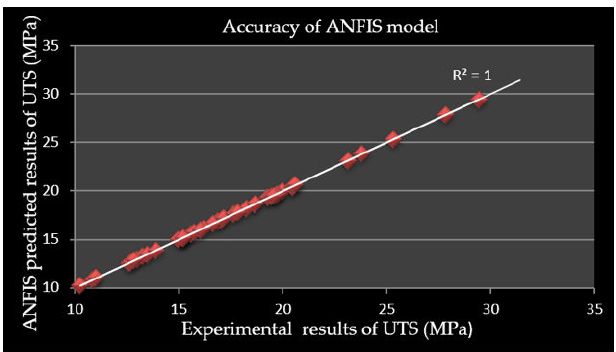
Figure 10. Regression results of the ANFIS